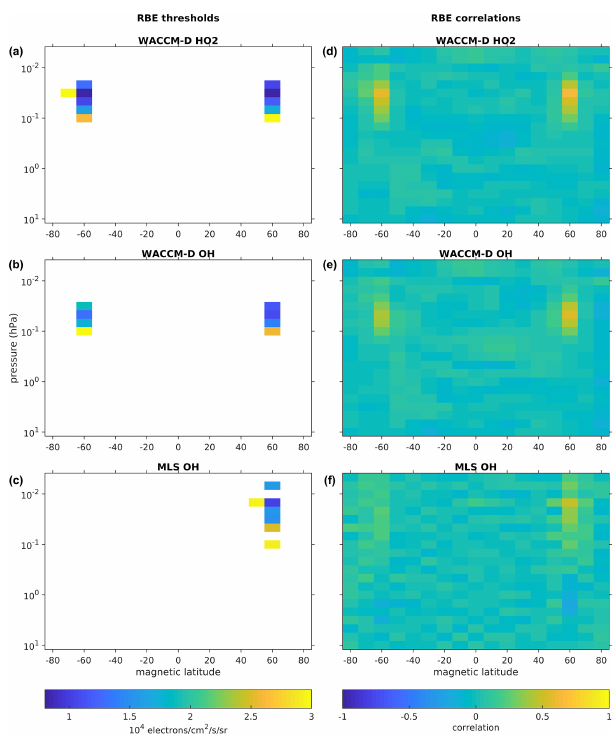
Figure 10. Nighttime RBE indicator thresholds (a–c) and corre- sponding correlations (d–f) . WACCM-D HO 2 (a, d) , WACCM-D OH (b, e) , and MLS OH (c, f) .